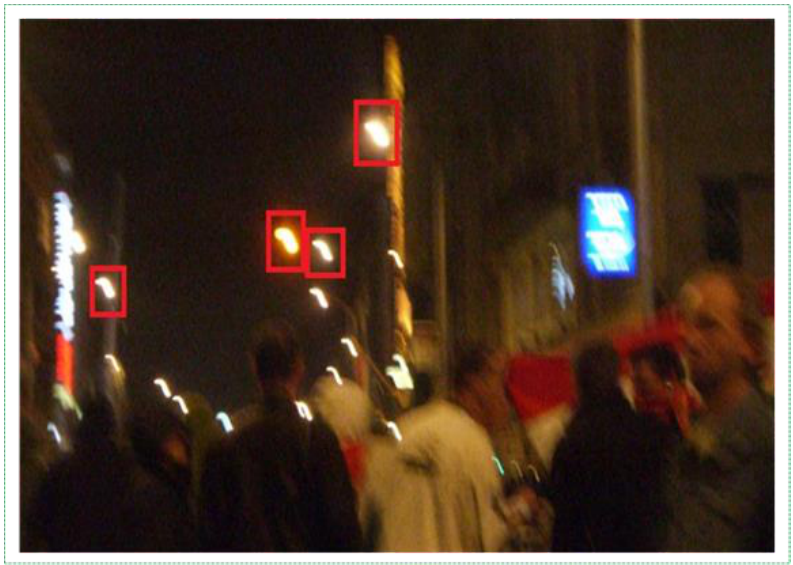
Figure 14. Blurred lamps at night time environments.